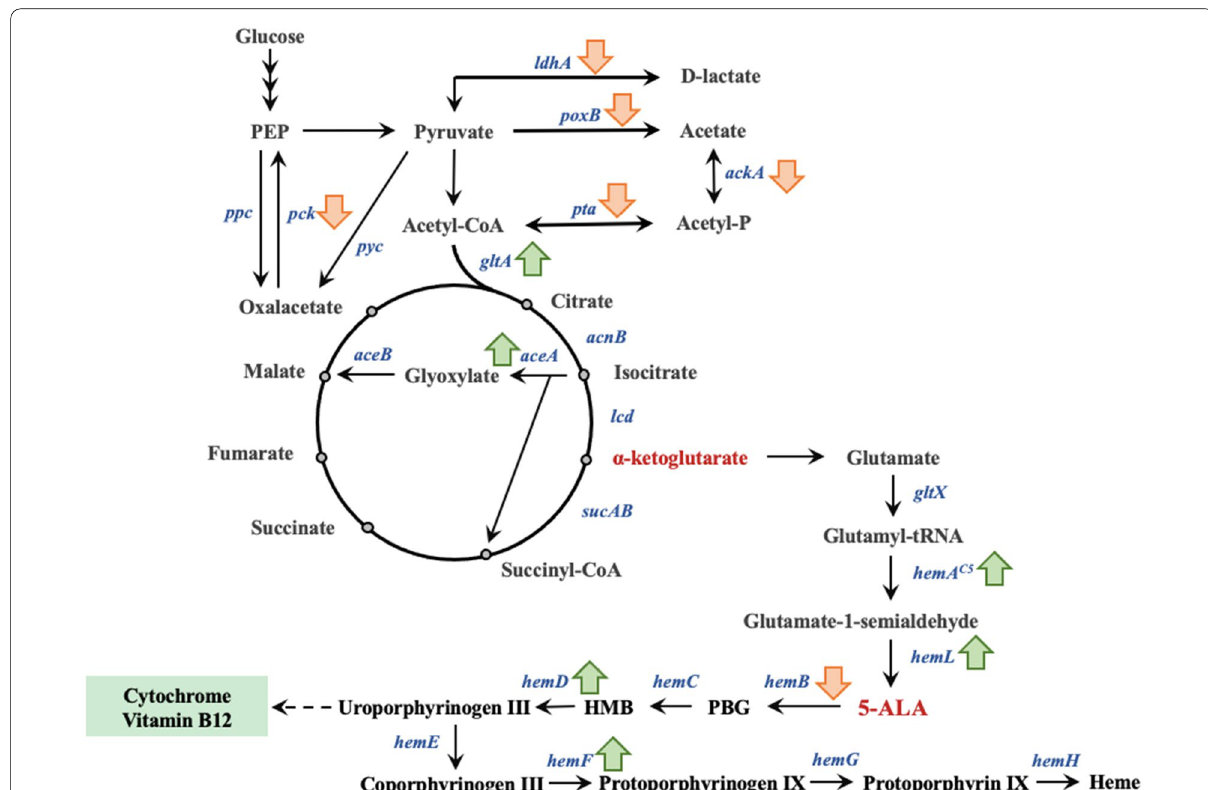
Fig. 2 The C5 pathway for 5‑ALA and heme synthesis. The up and down arrows beside the gene indicate the up‑ or down‑regulation of the gene which can increase 5‑ALA